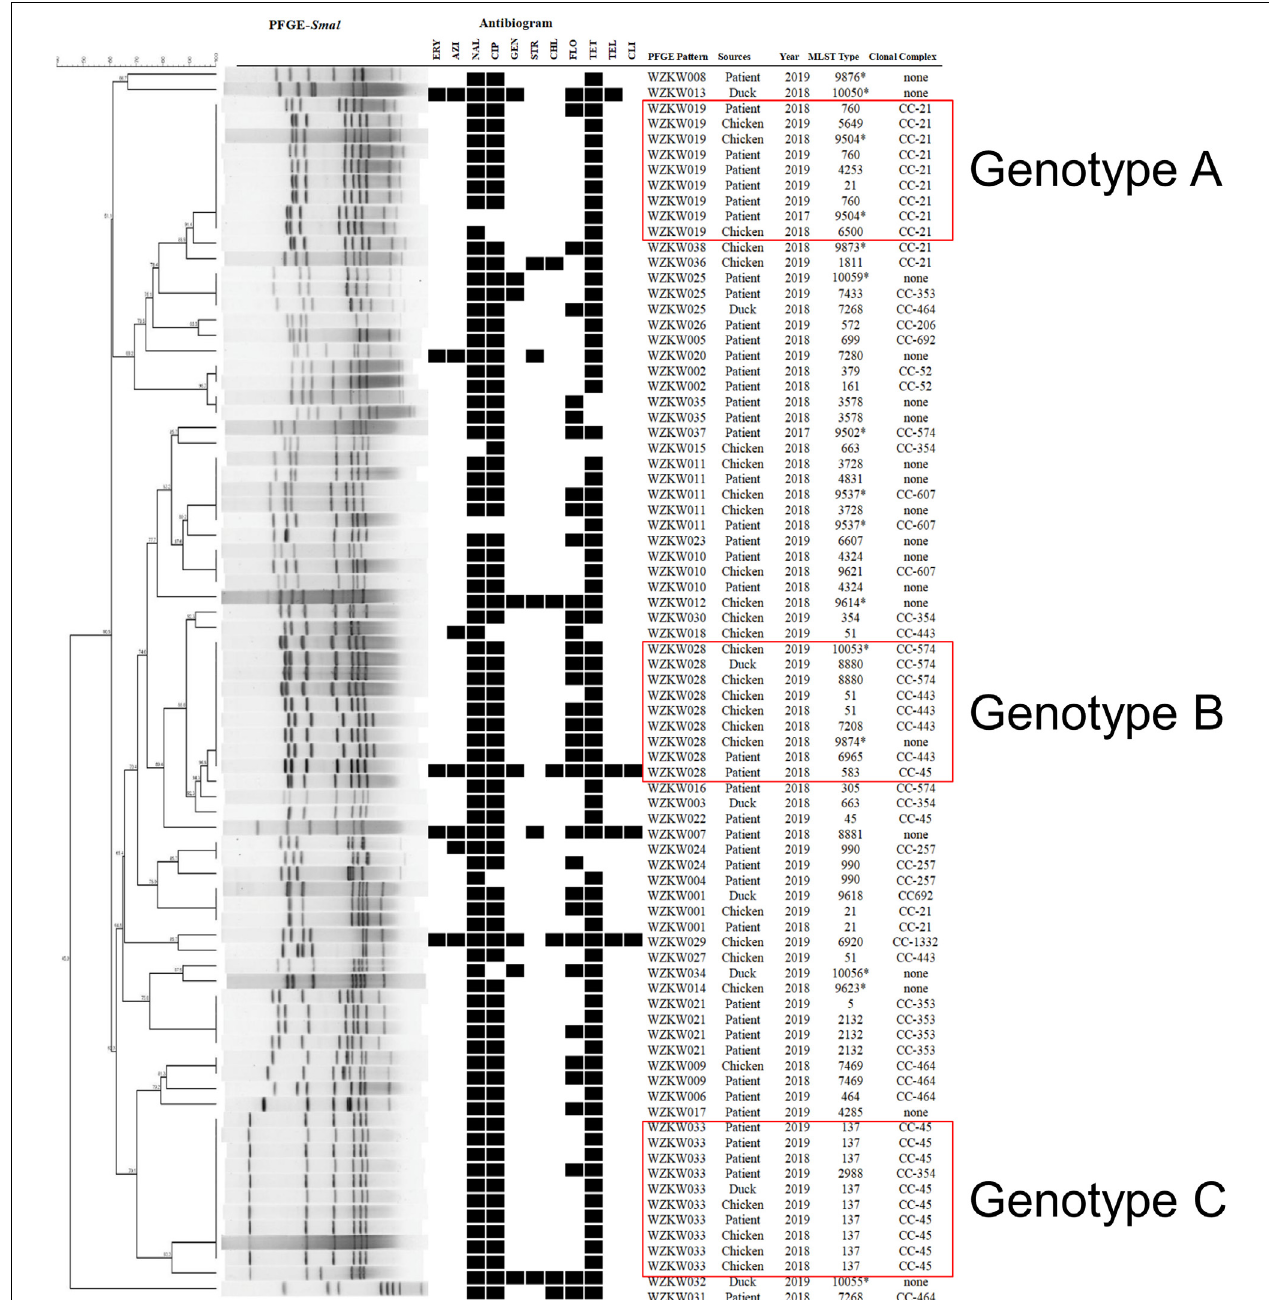
FIGURE 2 | Dendrogram of 80 C. jejuni strains based on Sma I-mediated PFGE profiles. PFGE pattern, strain source, isolation year, sequence type, and clonal complex are depicted. Asterisk indicates newly designated ST in this study. Black squares of the antibiogram indicate resistance to